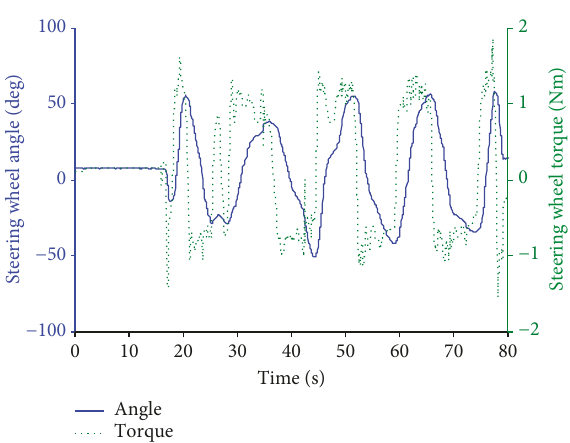
Figure 24: The relationship between steering wheel torque and angle.